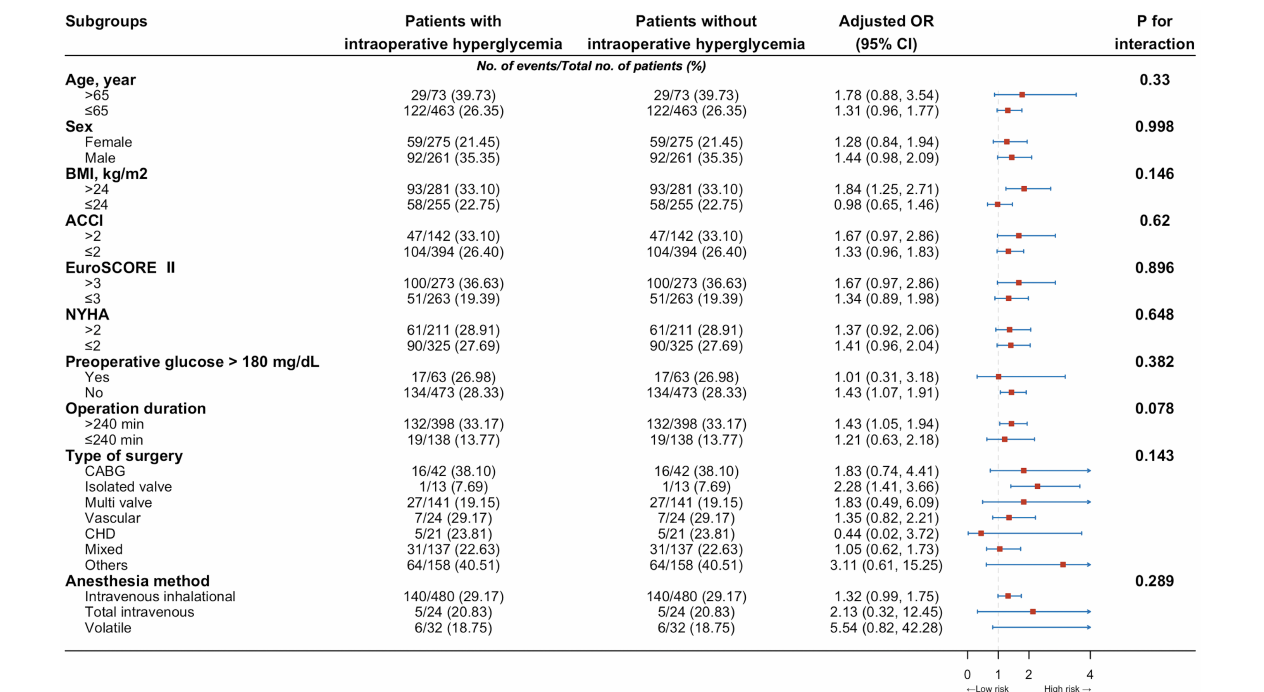
control strategy, leading to the evolution of two treatment dogmas.